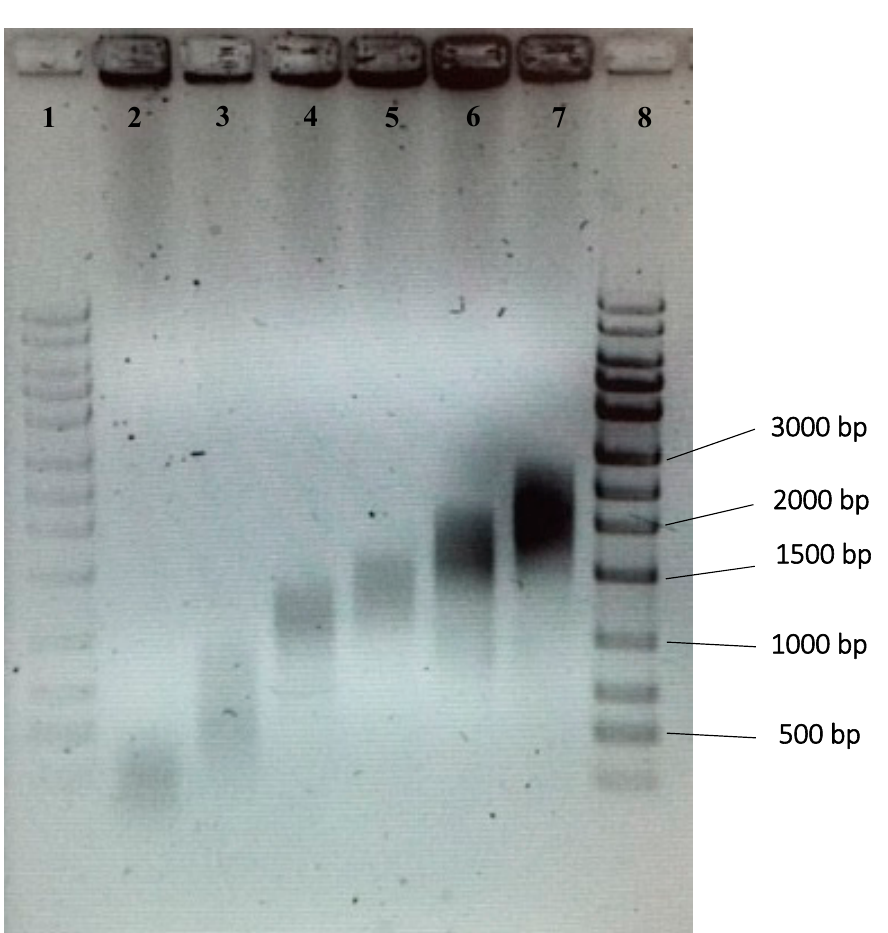
Figure 2. Gel photo of gDNA of various size ranges. Six different size ranges were used in the study.